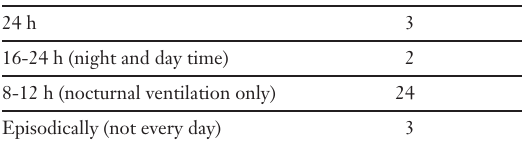
Table 5 Reasons for hospital admissions of chil- dren on home venti- lation in